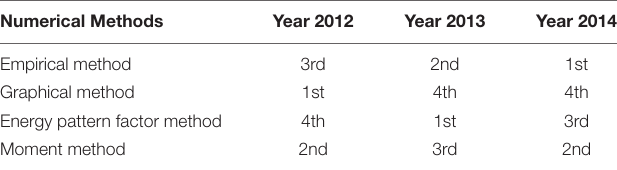
TABLE 6 | Rank of performance of numerical methods.